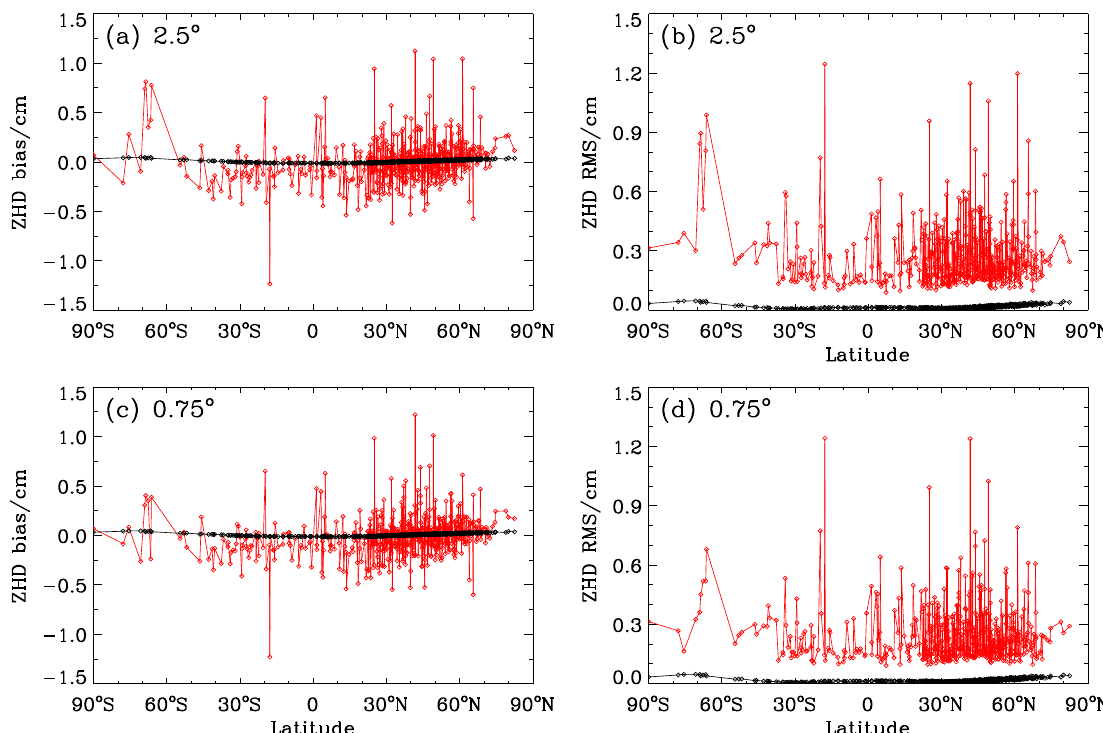
Figure 6. Distribution of station-specific bias ( a , c ) and RMS ( b , d ) values of ZHDs derived from ERA surface analysis data as well as local meteorological measurements. The reference ZHDs are calculated from radiosonde profiles over 530 IGRA stations. The red line refers to ZHDs obtained from the A&N model with P from ERA surface analysis data as input, and the black line refers to those obtained with in situ P measurements.